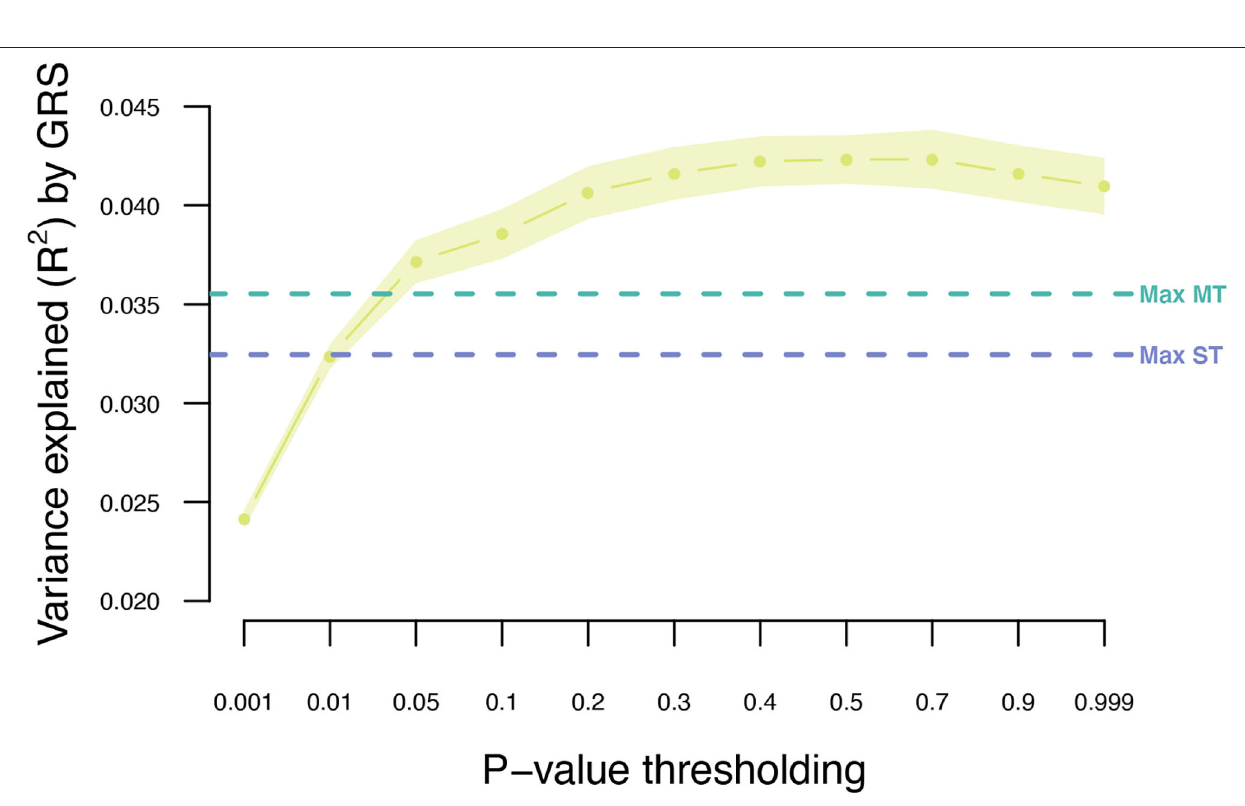
FIGURE 5 | Variance explained ( R 2 ) for type 2 diabetes using MT model with the seven information traits and publicly available T2DM summary statistics. Points indicate mean R 2 for a given threshold, and the surrounding shading indicates the standard error of the mean. The horizontal dashed lines indicate the maximum R 2 obtained for ST-GRS and MT-GRS without publicly available summary